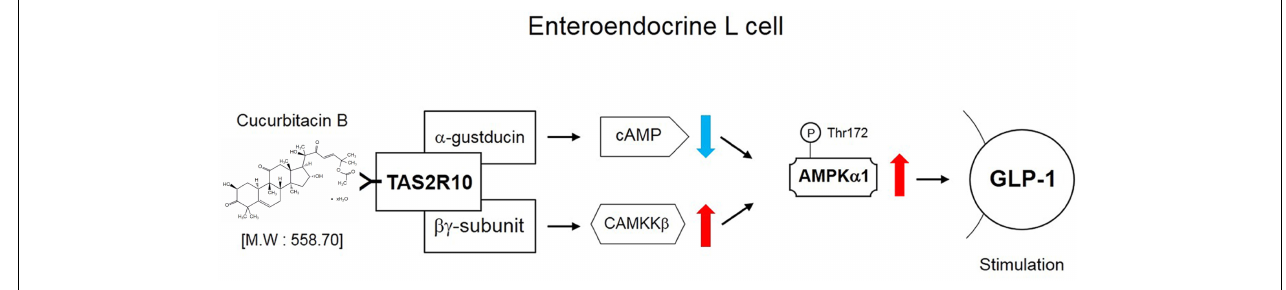
FIGURE 7 | Schematic signaling pathway of CuB effects. The schematic signaling pathway of CuB in differentiated enteroendocrine L-cells.